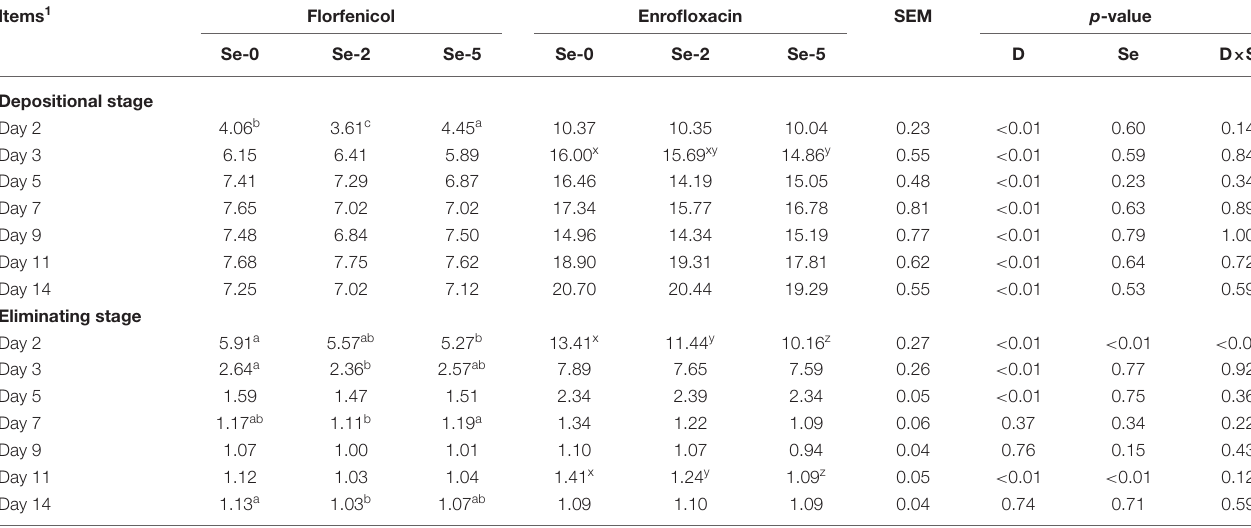
TABLE 8 | Effects of dietary organic selenium on residue of drugs in eggs of laying hens. Items